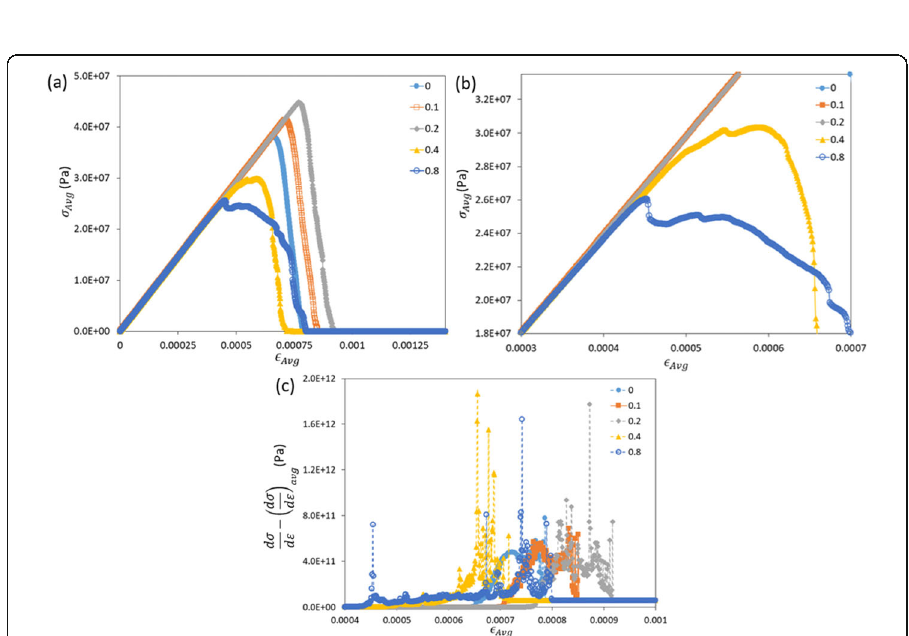
Fig. 14 Quantification of the fluctuations at crack nucleation and growth of average stress: Simulations of sample size L x = 8 μ m, L y = 0.5 mm, and L z = 1.0 mm where D = 2.995 and W = 64 μ m as a function of the average strain where ( a ) is the average stress vs. average strain, ( b ) is the zoomed-in view of the fluctuations for disorder strengths 0.4 and 0.8, and ( c ) is the difference in the rate of change of the average stress and the initial rate of change of linear increase in average stress vs. average strain. . The figure legends signify the disorder variance ratio R G that varies from 0.0 to